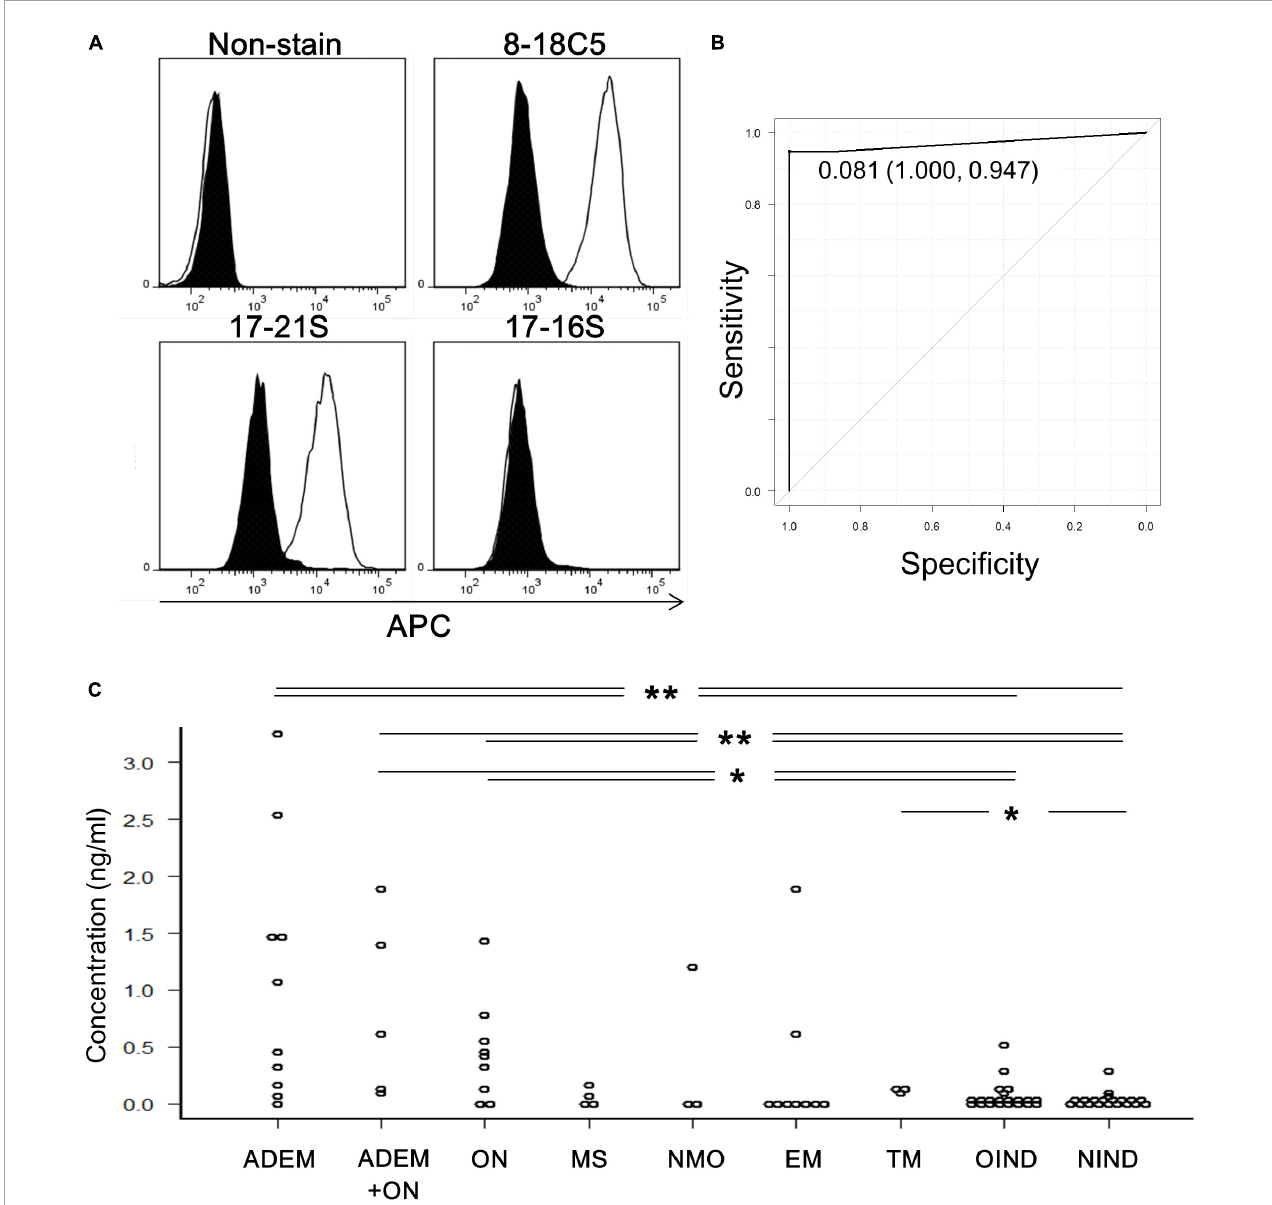
FIGURE1 Titration of anti-MOG antibody by flow cytometry. (A) Representative histograms of cells stained with only the second antibody (non-stain), 8–18C5, or patients’ sera (17–21S; anti-MOG positive, 17–16S; anti-MOG negative). The APC intensity of empty cells (closed) and MOG-GFP cells (open) are shown. (B) An ROC curve from 35 samples for evaluation of the screening efficacy and for identification of a cutoff point of serum anti-MOG titer level. (C) Anti-MOG antibody titer ratios in various diseases (ADEM; 10, ADEM + ON; 5, ON; 9, MS; 4, NMO; 3, EM; 9, TM; 3, OIND; 21, and NIND; 20). Statistical analysis was performed using Kruskal–Wallis test and Steel–Dwass test (* P < 0.05, ** P < 0.1).